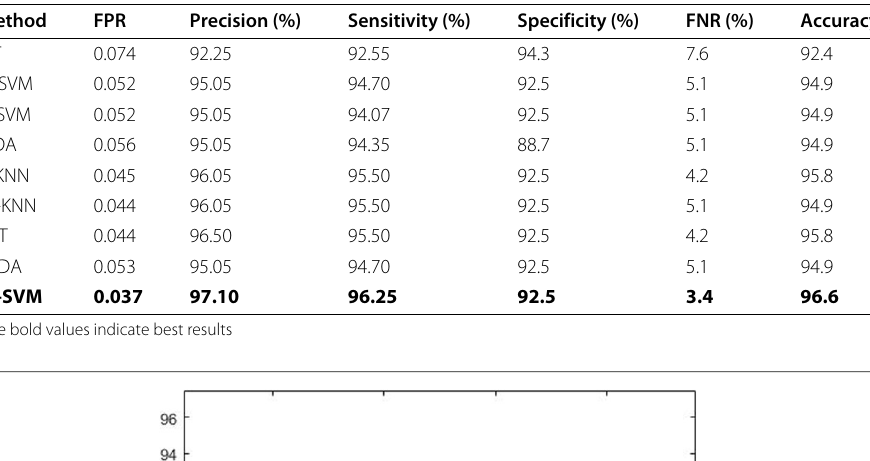
Table 14 Classification results on the proposed feature selection approach for grapes rot leaves